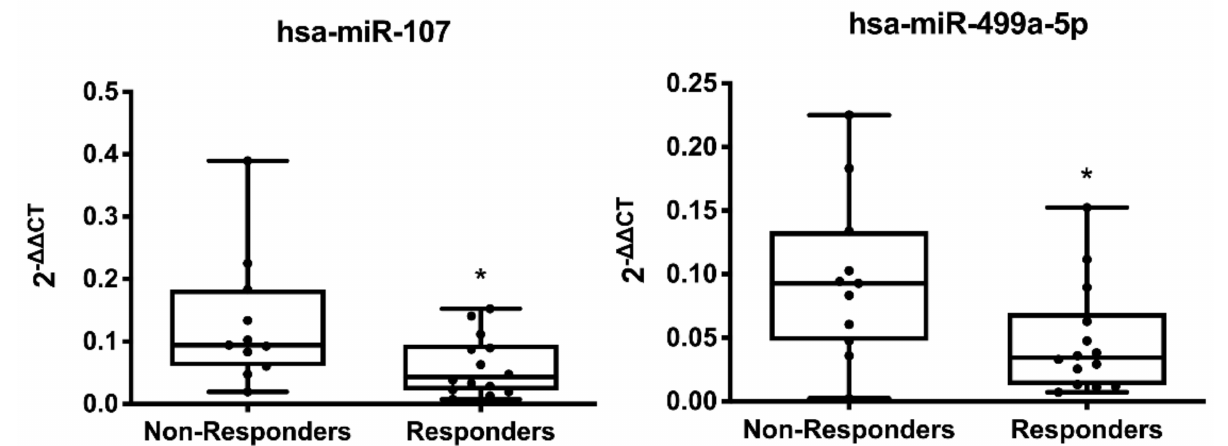
Figure 2. Differential baseline expression of miRNAs between CRT responders and non-responders. Box-and-whiskers min to max plots showing plasma levels of microRNAs. Data correspond to baseline differentially expressed miRNAs in non-responder ( n = 11) vs. responder ( n = 14) patients. * p < 0.05 responders vs. non-responders.